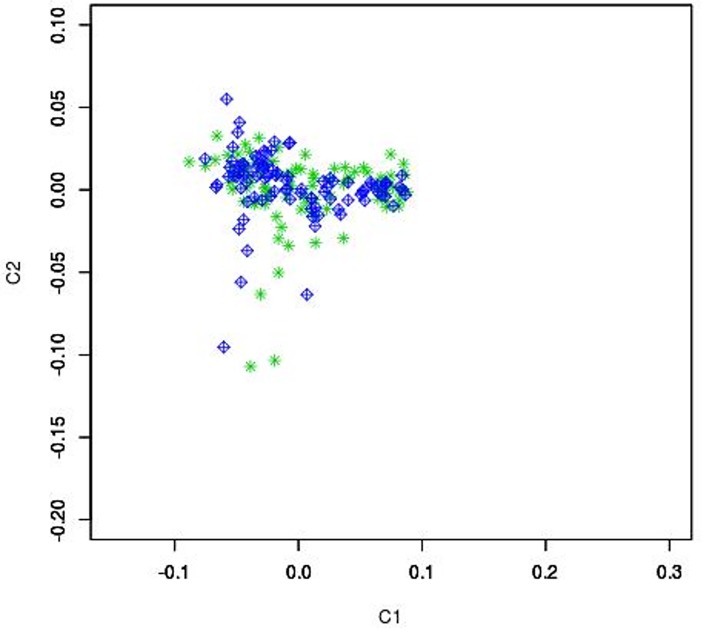
Scatter plot for the first 2 dimensions.The x-axis is principal component 1 and y-axis is principal component 2. Green: case, Blue: control.